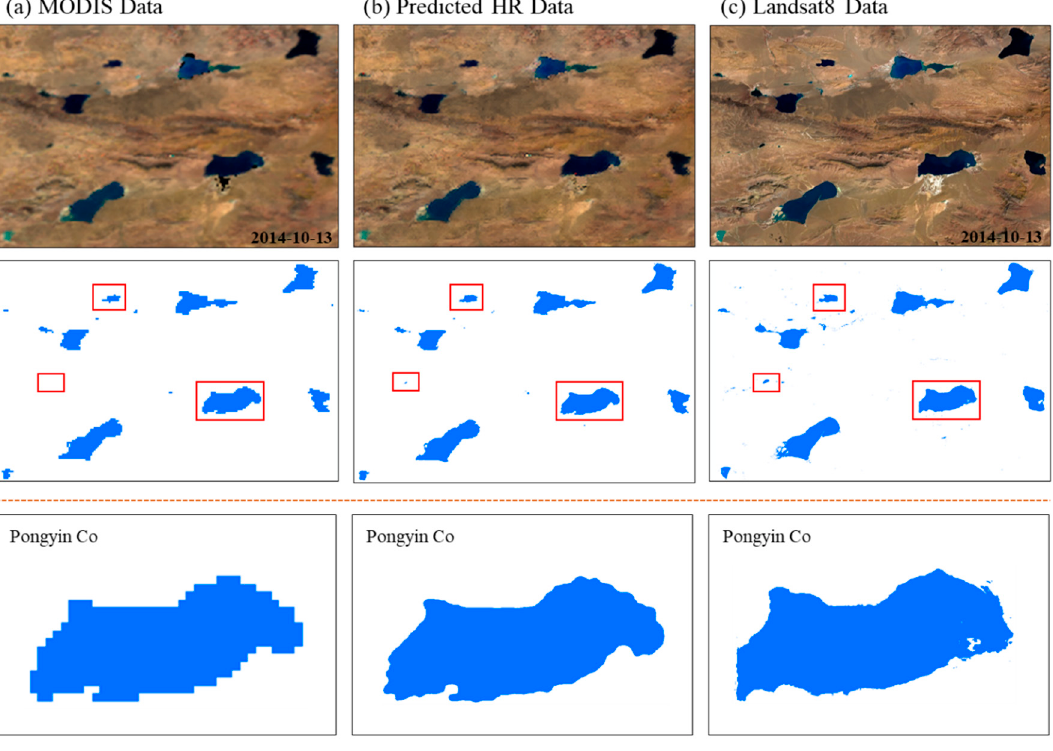
Figure 9. SR Results of real-world situations. MODIS image with an original spatial resolution of 500 m is improved to 30 m resolution. ( a ) MODIS data, ( b ) Predicted HR data, ( c ) Landsat 8 data.